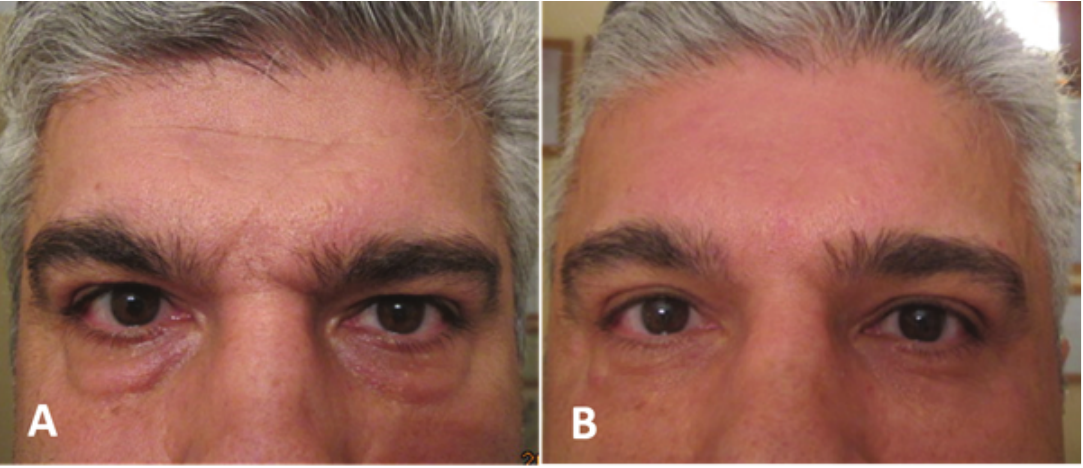
Figure 11. A male patient with good frontal hairline (A) who underwent endoscopic forehead lift and upper blepharoplasty procedures and ended up with a good eyebrow lift two and a half years after the surgery (B).